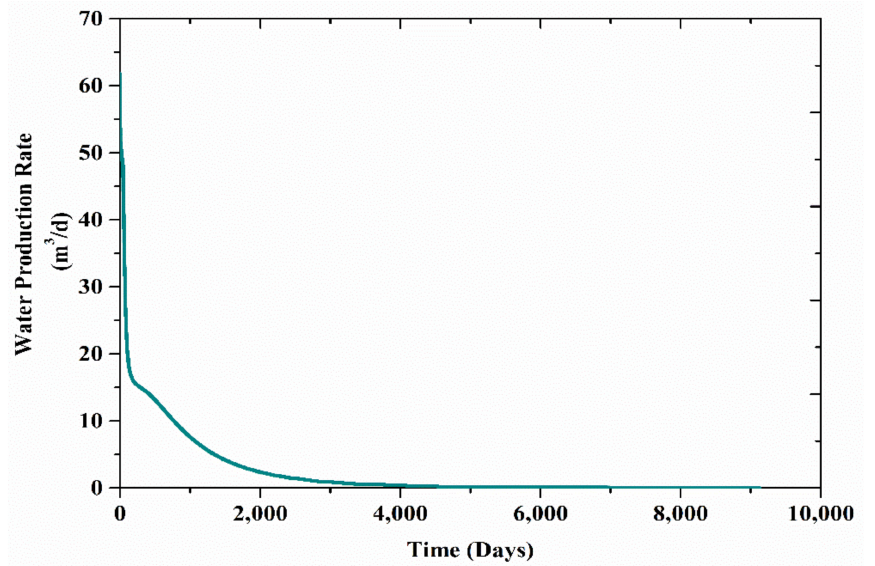
Figure 8. Water production rate vs.